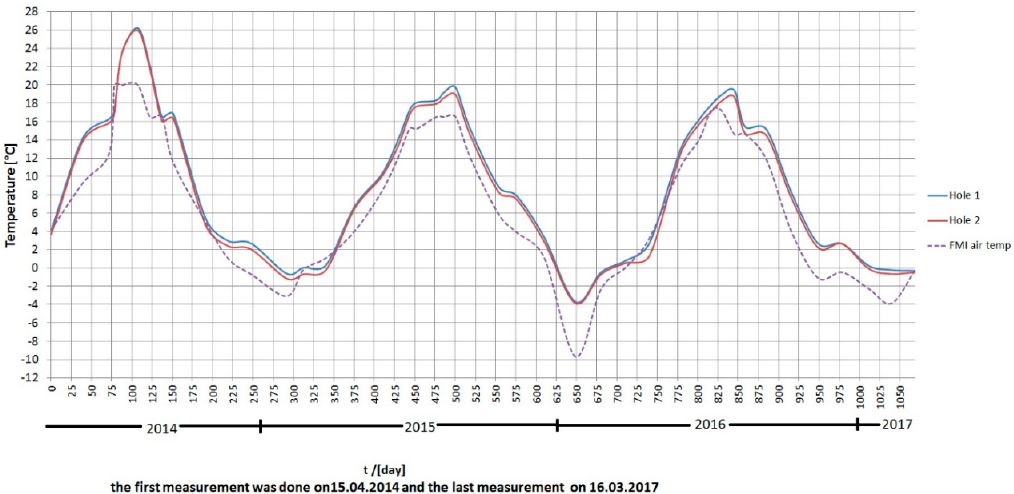
Figure 3. The temperature at a 0.5 m depth under the asphalt layer in two different holes, and the average air temperature of the month [23]. Table 1. The monthly mean air temperatures [°C] measured during April 2014–March 2017 at the weather station of the Finnish Meteorological Institute [23].